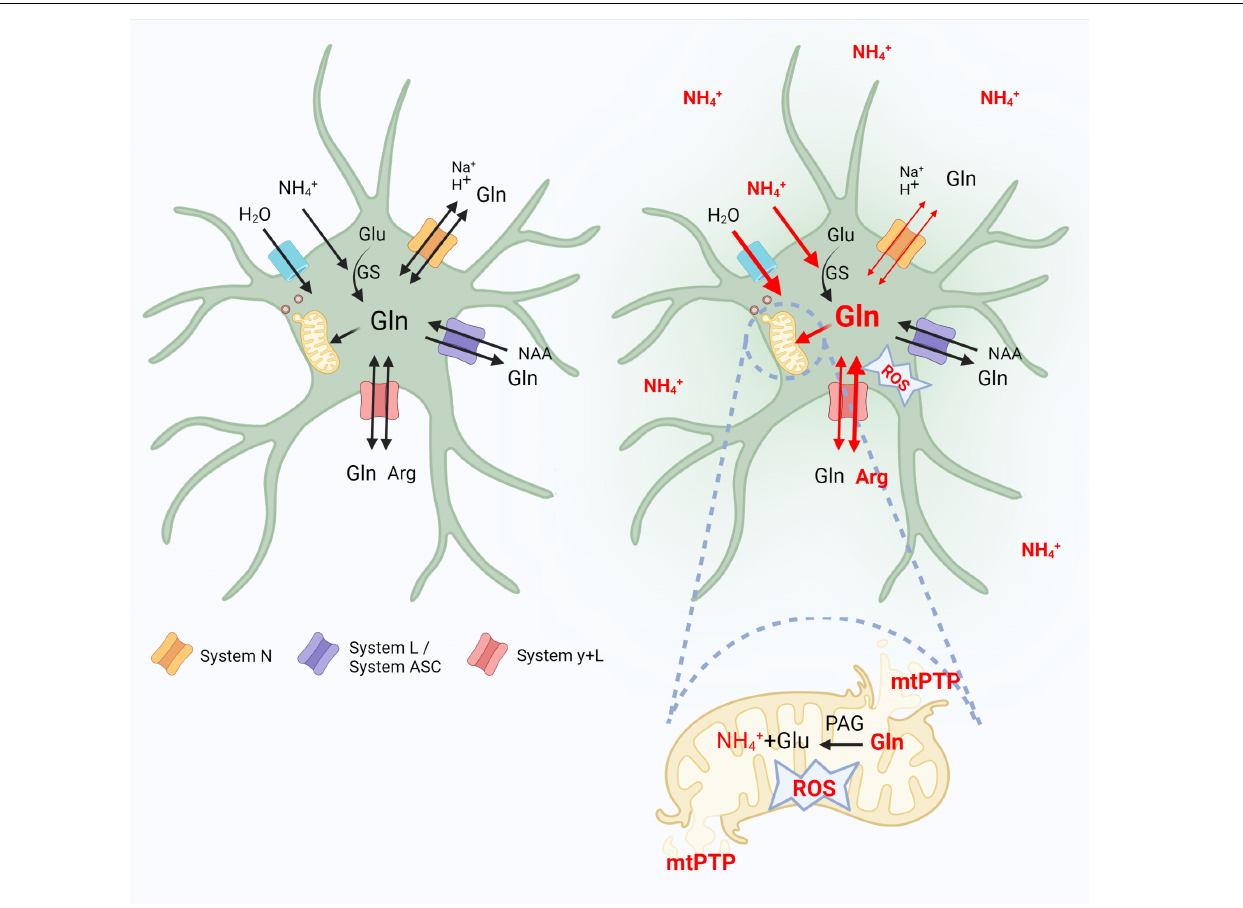
FIGURE 1 | Contribution of astrocytic glutamine transporters belonging to systems N, L/ASC and y + L to the glutaminosis-driven aspect of brain edema in acute hyperammonemia. Left panel indicates control conditions. In the right, where the effects of hyperammonemia are outlined, thin or thick red lines indicate decreased or increased activity of a given event, respectively. Glu, glutamate; Gln, glutamine; Arg, arginine; GS, glutamine synthetase; NAA, neutral amino acids; ROS, reactive oxygen species; mtPTP, mitochondria permeability transition pore. Created with BioRender.com.